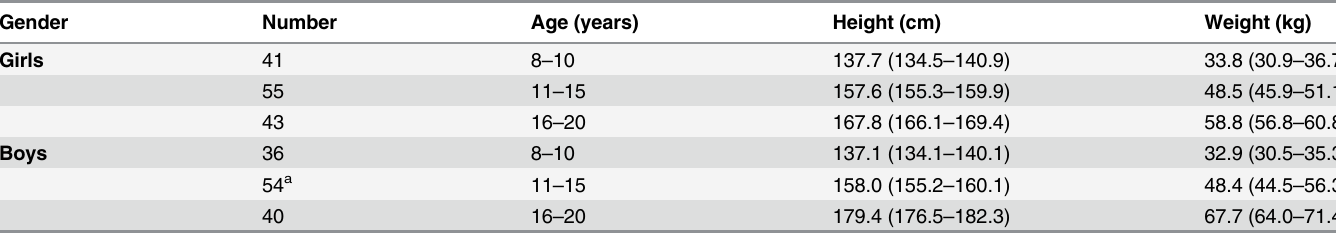
Table 1. Height and weight of the 269 healthy children included in the study.